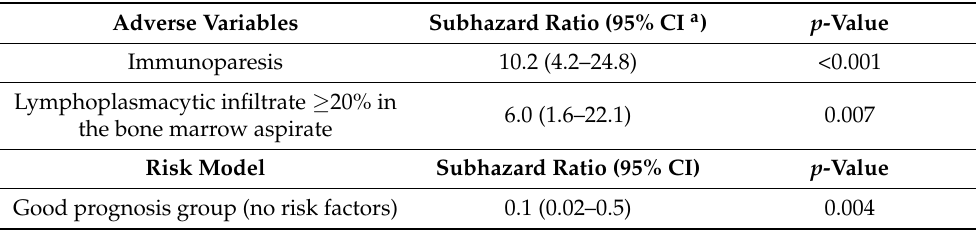
Figure 2. Cumulative incidence of progression in the framework of death as a competing event, according to immunoparesis ( a ) and bone marrow (BM) lymphoplasmacytic infiltration ( b ) at diagnosis of asymptomatic IgM monoclonal gammopathy. Table 3. Risk stratification model of progression to WM in patients with asymptomatic IgM mono- clonal gammopathy as determined in the framework of death as a competing